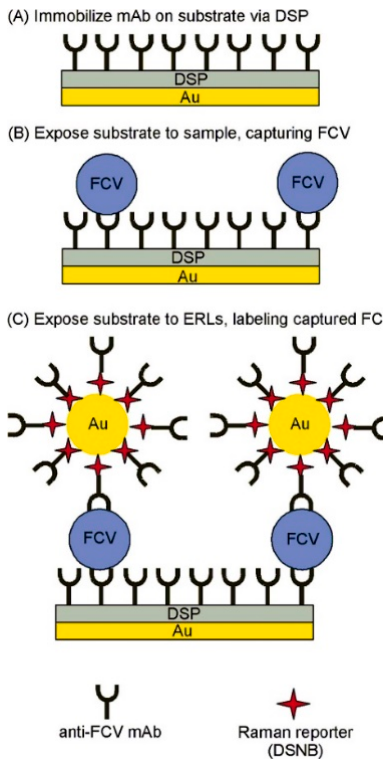
Figure 1. Detection of feline calicivirus (FCV) by extrinsic surface enhanced Raman scattering (SERS) (reprinted from Driskell et al. [129] with permission from the publisher).